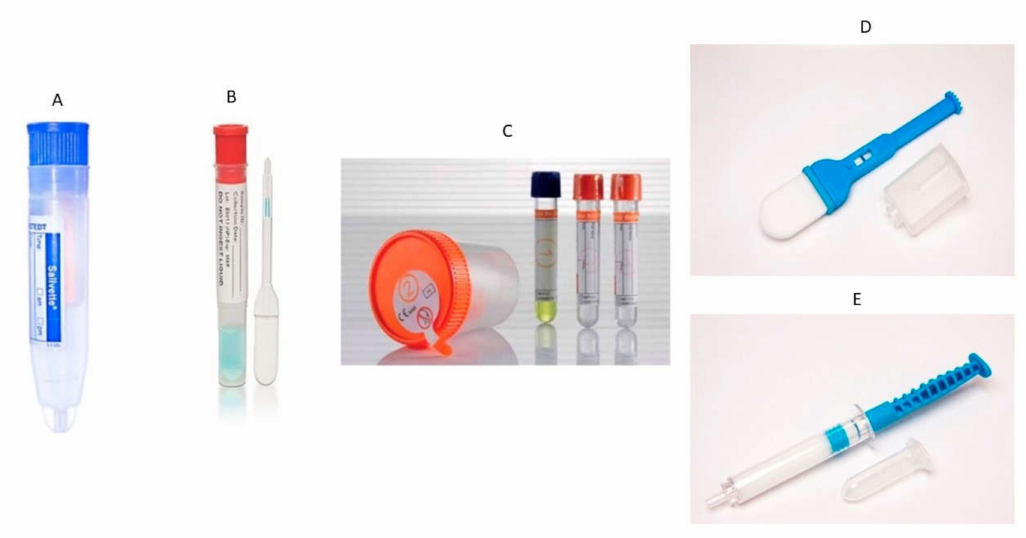
Figure 2. Representation of di ff erent saliva collection devices used in the sampling of contagious infectious diseases. ( A ) Salivette ® (Sarstedt); ( B ) Quantisal ® (Immunalysis); ( C ) SCS ® (Greiner-BioOne), ( D ) Versi • SAL ® , and ( E ) Super • SAL ™ by Oasis Diagnostics ® Corporation